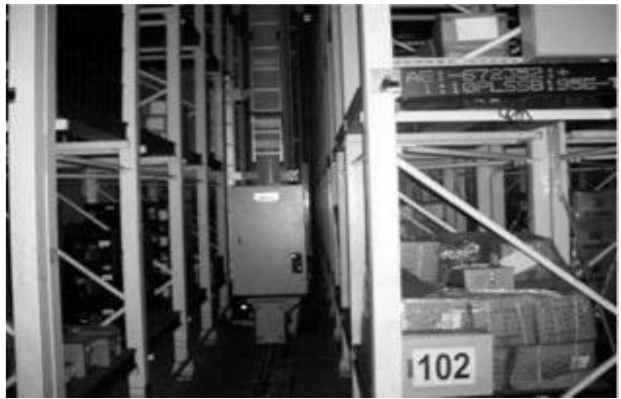
Figure 1. A single-aisle/double-rack